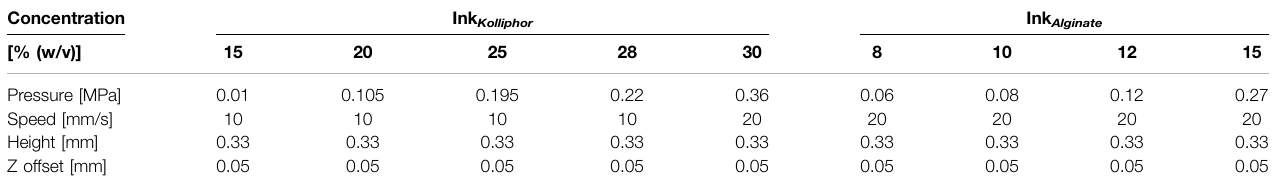
TABLE 1 | Printing parameters for testing the sensor accuracy with inks of different alginate and Kolliphor concentrations. Z offset is the distance between nozzle and substrate when the fi rst layer is printed. Concentration Ink Kolliphor